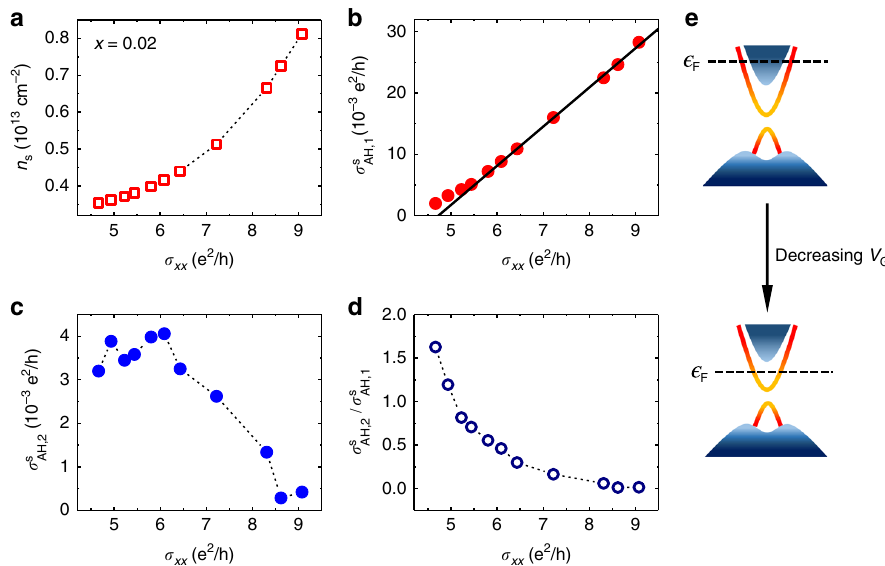
Fig. 5 Characteristics of the AH conductivity in a lightly doped (Bi 1 − x Mn x ) 2 Se 3 sample ( x = 0.02). a Sheet carrier density n s as a function of sheet conductivity σ xx . b , c σ xx dependences of the magnitudes of the positive and negative AH conductivities above the saturation fi elds, σ AH ; 1 (panel b ) and σ AH ; 2 = σ s (panel c ). d The ratio of the AH components, σ s , plotted as a function of σ xx . e Schematic band diagrams for high and low Fermi levels. The data AH ; 2 AH ; 1 shown in panels a – d were extracted from the Hall effect data taken from Sample C at T = 1.6 experiment on Mn-doped Bi 2 (Te,Se) 3 thin fi lms, in which the AH